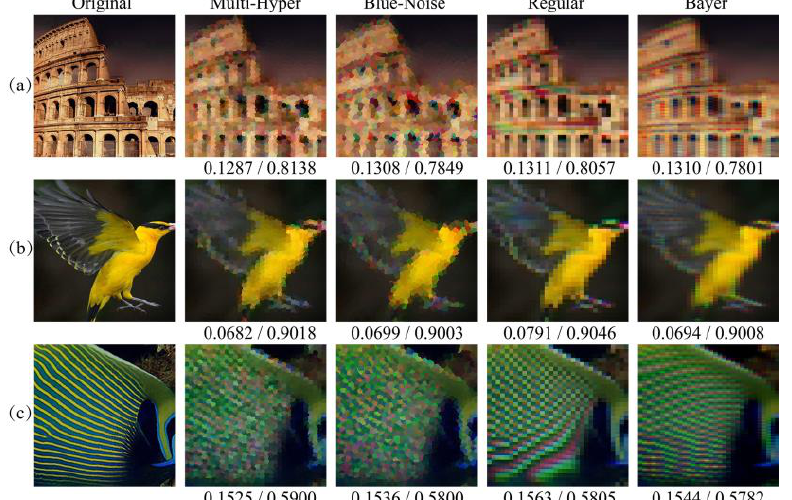
Figure 6. Comparison of reconstructed images of artificial scenes using different sampling patterns. From the left to right are the original images, reconstructions from multi-hyperuniform, regular and Bayer sampling patterns. The corresponding RMSEs and SSIMs are listed below the images, respectively. ( a ) The scene of Colosseum with color transition area and corresponding reconstructed images in numerical simulations; ( b ) The scene of bird with periodic patterns on the wings and corresponding reconstructed images; ( c ) The scene of fish with periodic stripes and corresponding reconstructed results.